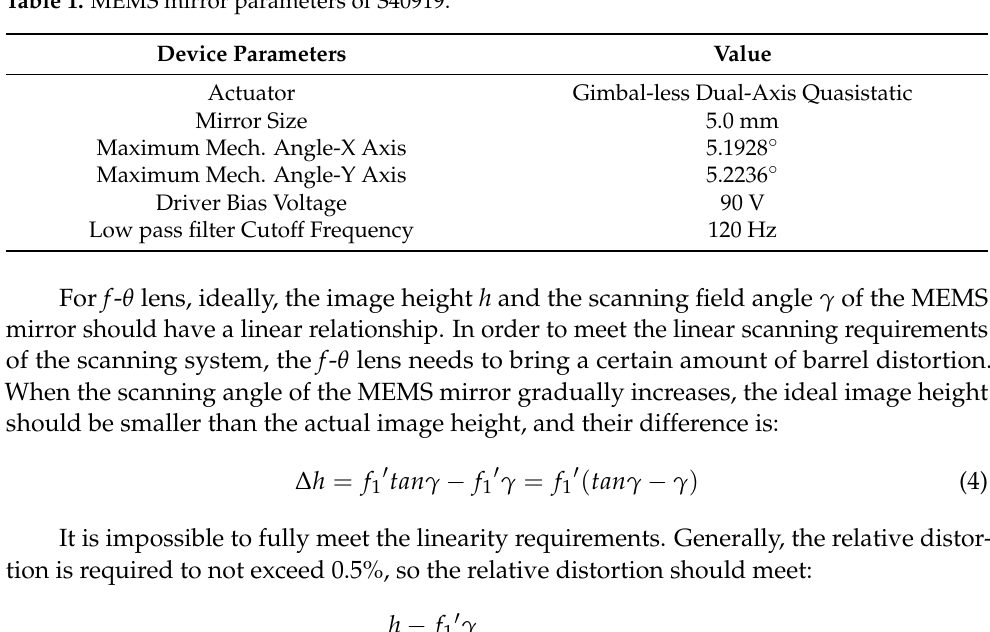
Figure 3. The relationship between drive voltage and tilt angle. Table 1. MEMS mirror parameters of S40919.